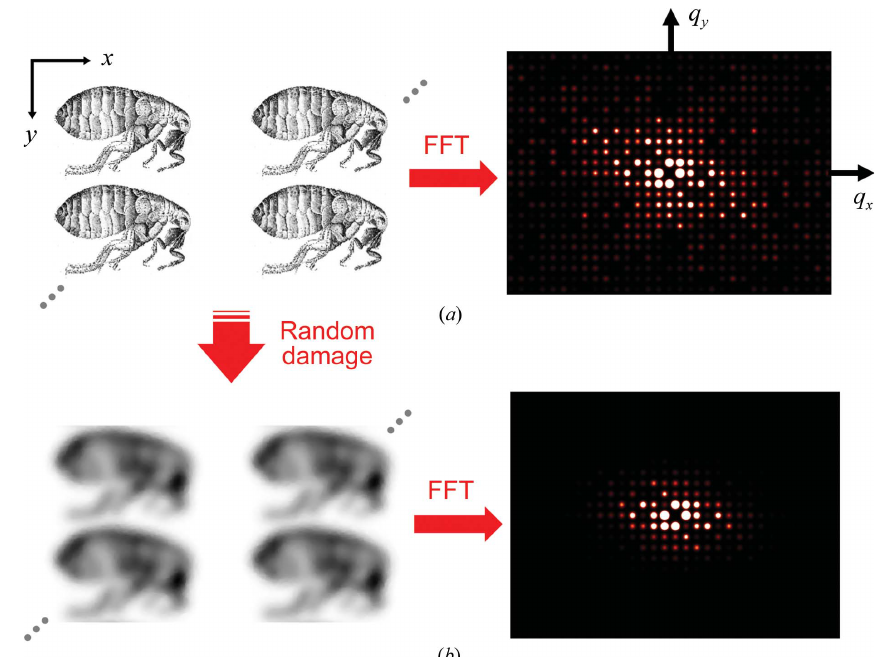
Figure 5 Simulation of radiation damage to a two-dimensional crystal formed of images of a flea (from Robert Hooke’s Micrographia ). Each ‘hit’ corresponds to the application of a local Gaussian blur at a randomly selected location (Supplementary Fig. S7). ( a ) Four unit cells (each 1024 (cid:6) 512 pixels) of the undamaged two-dimensional crystal (left) and the square of the FFTamplitude, proportional to the diffracted intensity, of a 16 (cid:6) 16 cell crystal (right). ( b ) After receiving a large number of hits (>>1 per pixel) the electron density has been blurred and the high-resolution (large q ) diffraction peaks have faded out. A full video of the evolution of the crystal and its diffraction pattern with dose is given in Supplementary Movies S1 and